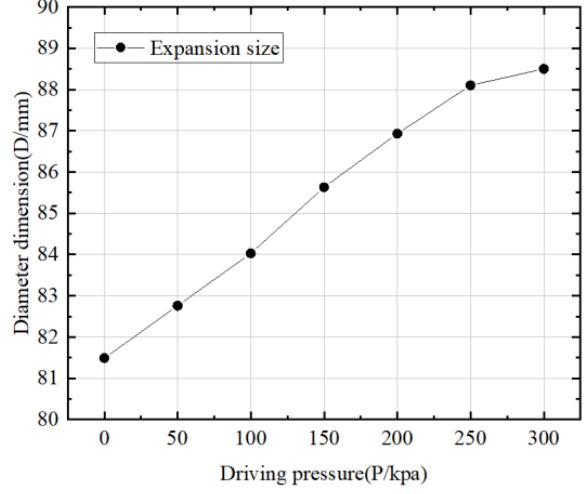
Figure 16. A characteristic curve of the hexagonal prism soft-bodied bionic actuator. Table 6. Comparison table of pipe inclination and minimum driving pressure. Tilt Angle ( ◦ ) Driving pressure